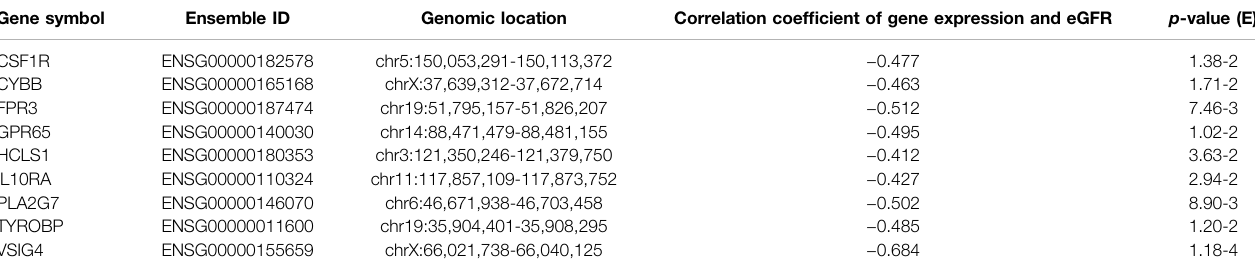
TABLE 2 | Information of the nine real hub genes.